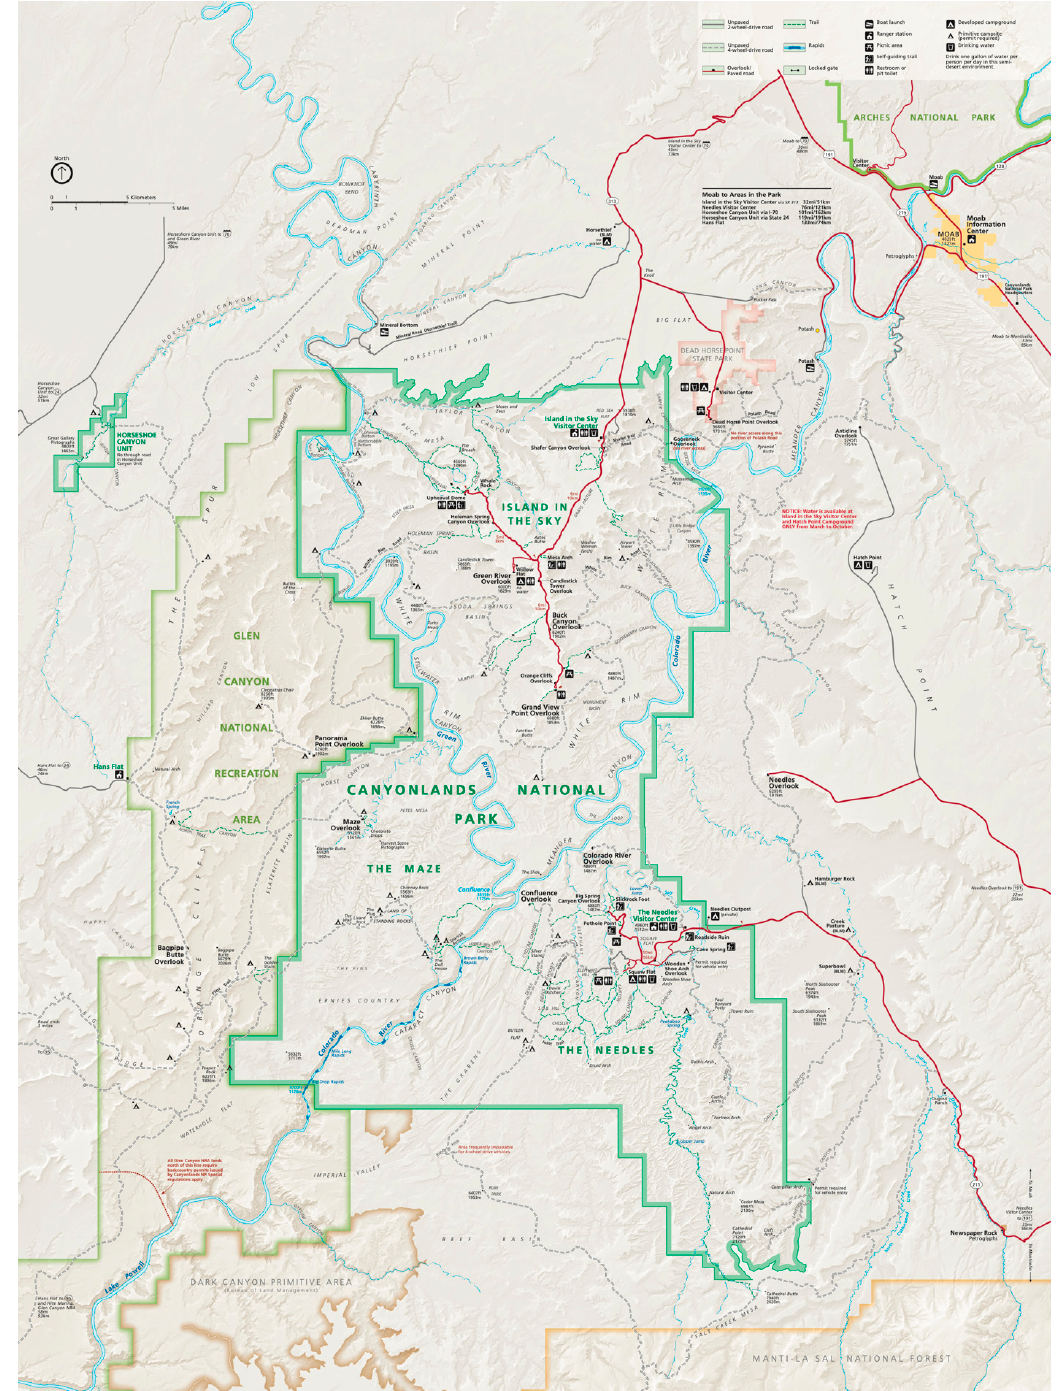
Figure 1. Map of Canyonlands National Park. Source: U.S. National Park Service.